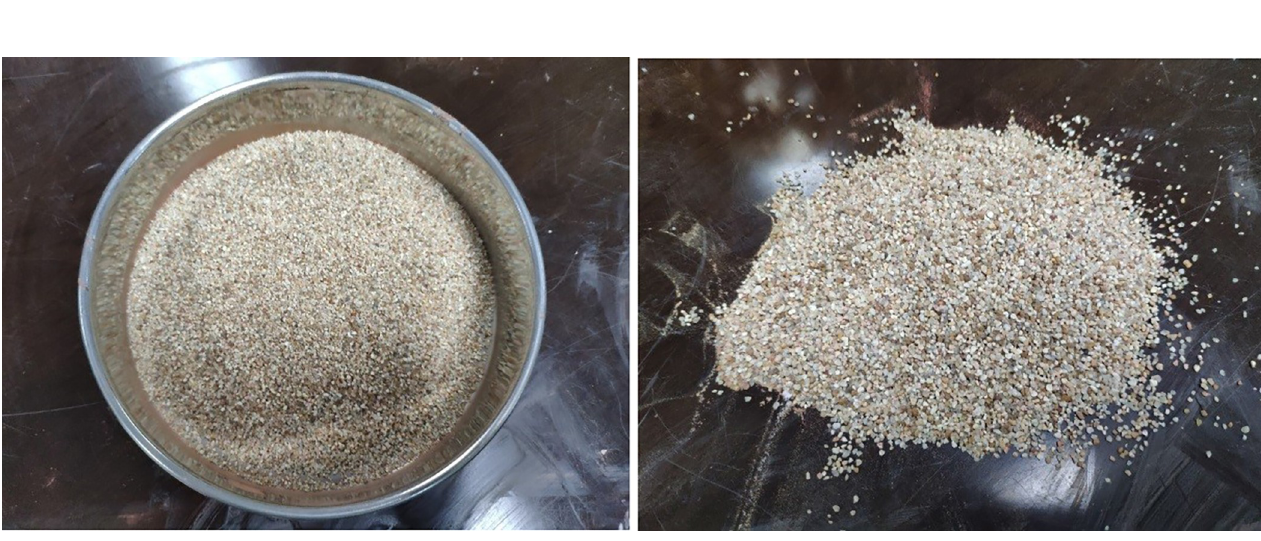
Fig 7. Simulated formation material.